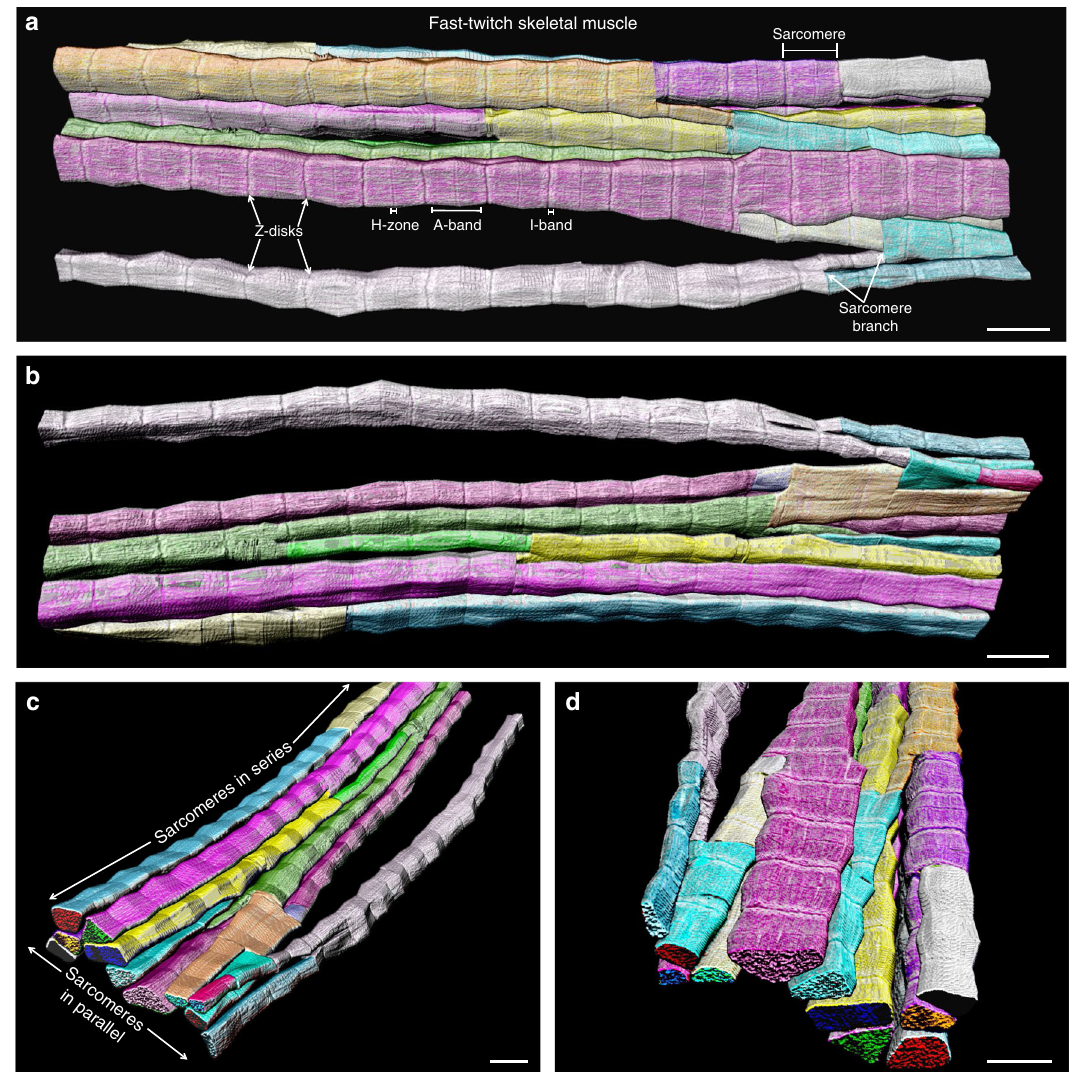
Fig. 1 Muscle myo fi brils form a highly connected matrix. a 3D rendering of 115 directly connected sarcomeres within the myo fi brillar matrix of a fast- twitch muscle. Individual colors represent different myo fi brillar segments linked by branching sarcomeres. b – d 3D renderings at different perspectives highlight the nonlinearity and connections between myo fi brillar segments. Representative of 7707 sarcomeres from four volumes from four mice. Scale bars, 2 µ